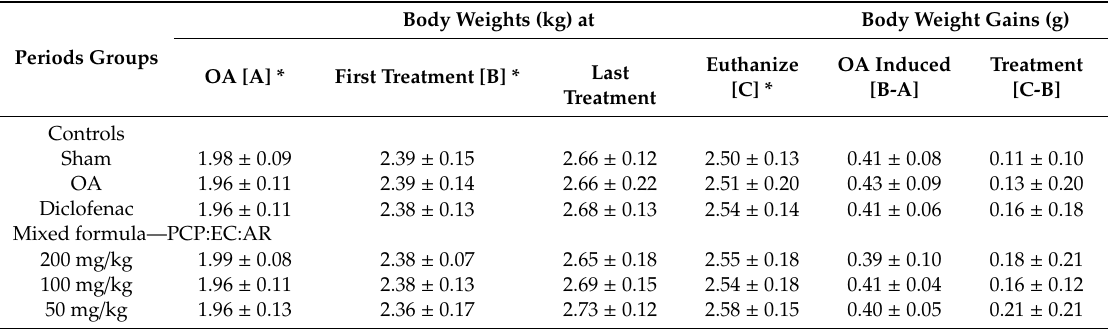
Table 1. Body weight gains in sham-operated or OA rabbits.